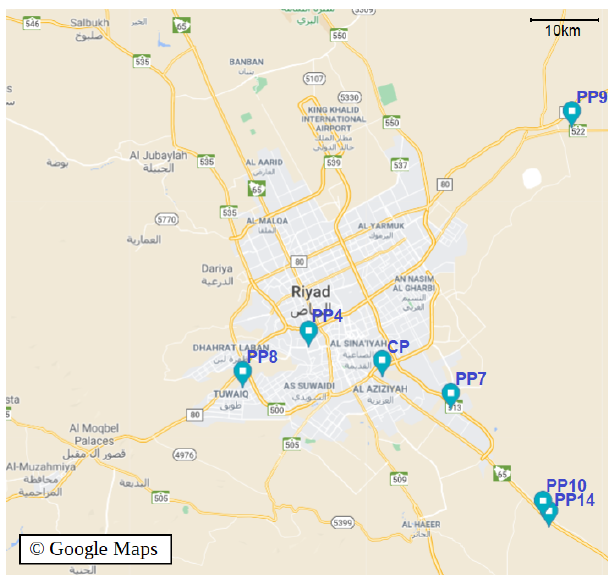
Figure 2. Map of Riyadh’s city centre with the surrounding power plants (PP4, 7, 8, 9, 10 and 14) and cement plant (CP). The map has been extracted from © Google